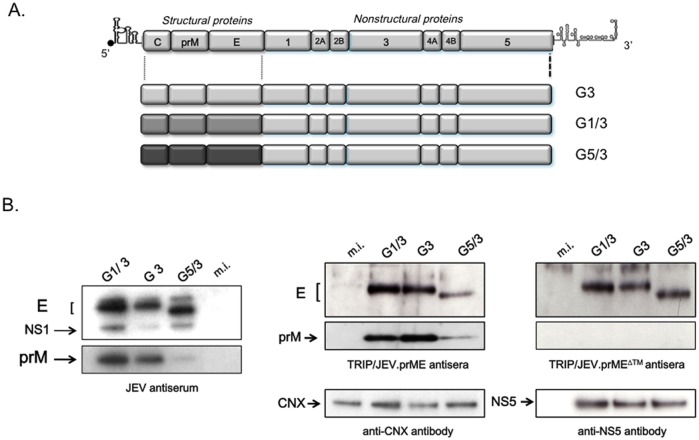
Construction strategy of chimeric live JEV and their recognition by TRIP/JEV antisera.
In (A), schematic diagram of chimeric JEV G1/3 and G5/3 which include the sequences encoding C, prM and E from JEV of G1 or G5 into the backbone of JEV of G3. The parental JEV was designed as JEV G3. In (B), recognition of chimeric JEV proteins by JEV antiserum or TRIP/JEV antisera. Lysates obtained from SK-N-SH cells infected with parental JEV G3, chimeric JEV G1/3 and G5/3, or mock-infected (m.i.) were analyzed by immunoblotting with the indicated antibodies. Anti-JEV NS5 (NS5) and anti-calnexin (CNX) antibodies served as controls.